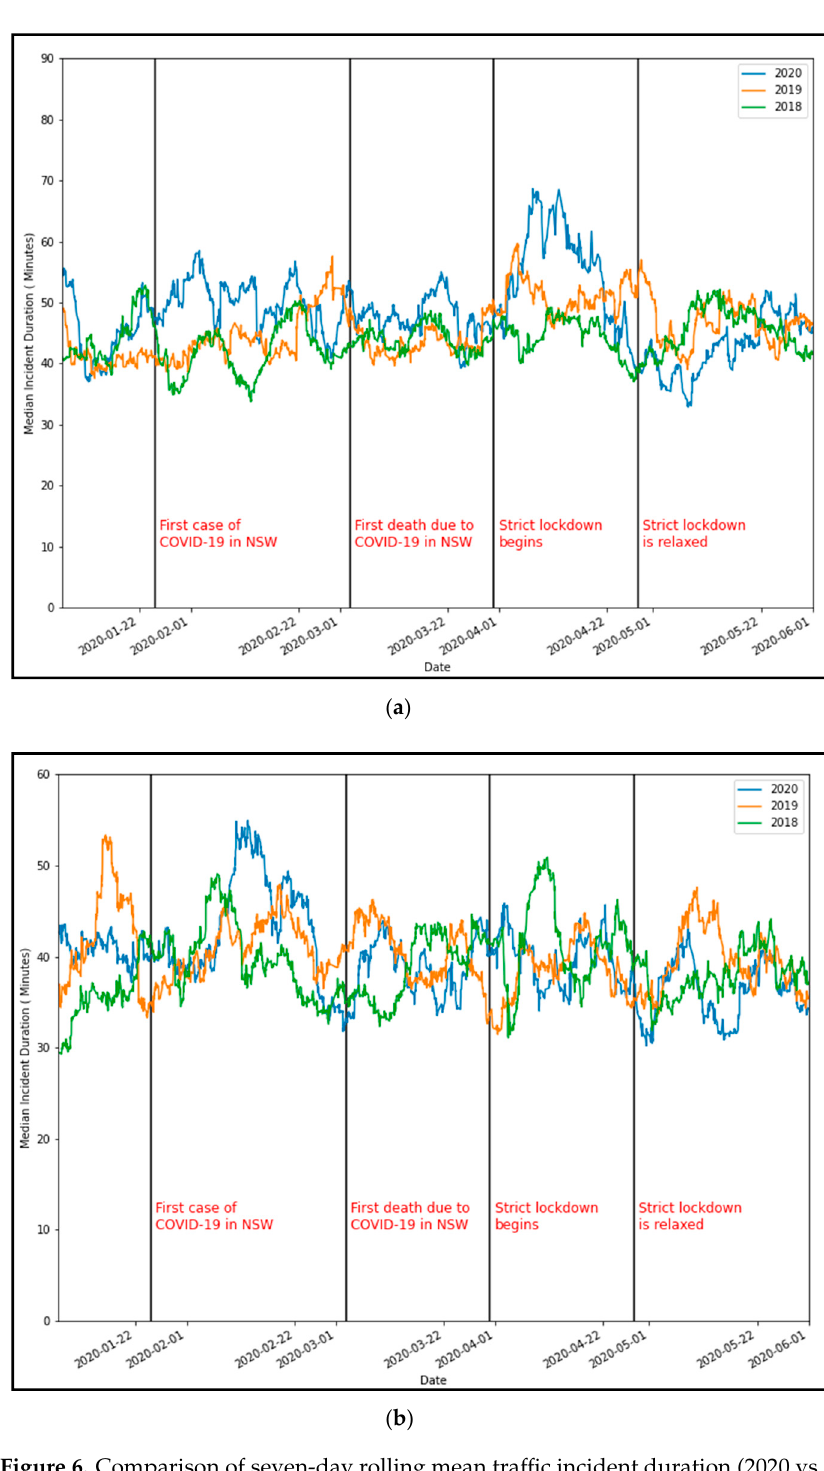
Figure 6. Comparison of seven-day rolling mean traffic incident duration (2020 vs. 2018 and 2019). ( a ) Crash duration and ( b ) breakdown duration.